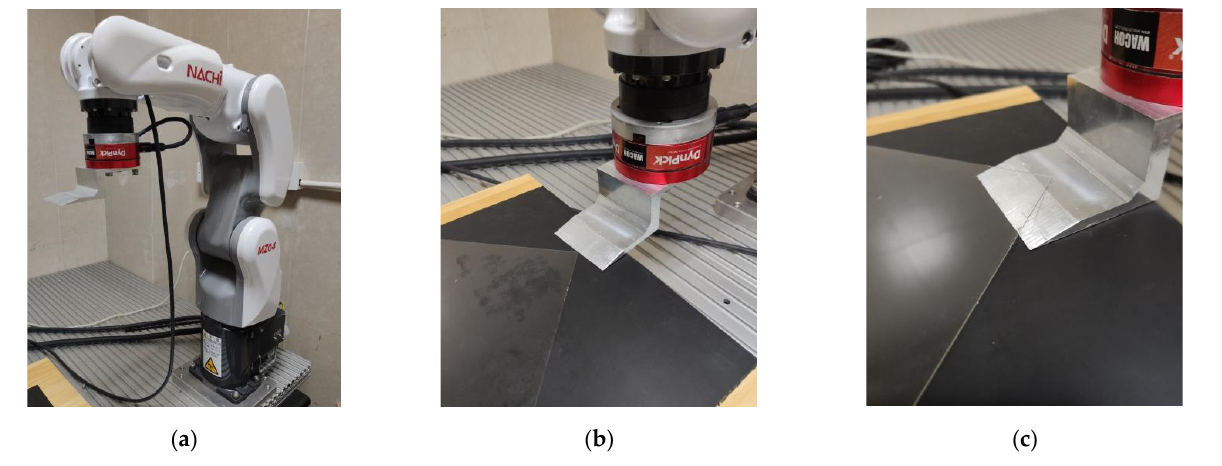
Figure 7. Experiment platform. ( a ) Layout of the system. ( b ) Starting point of peeling. ( c ) End of peeling.